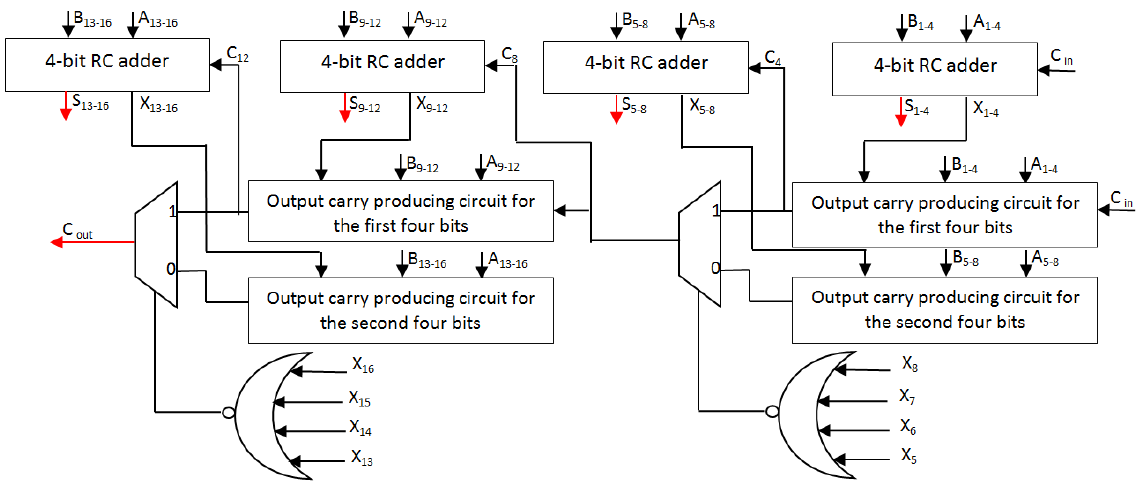
Figure 9. Proposed 16-bit adder.